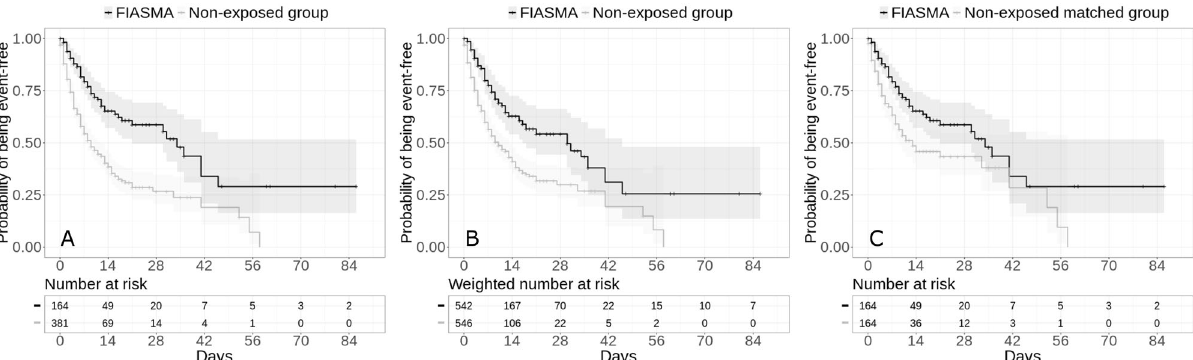
Fig. 2 Kaplan-Meier curves for the composite endpoint of intubation or death among patients with psychiatric disorders hospitalized for severe COVID-19, according to FIASMA psychotropic medication use at baseline. Kaplan – Meier curves for the composite endpoint of intubation or death in the full sample crude analysis ( N = 545) ( A ), in the full sample analysis with IPW ( N = 545) ( B ), and in the matched analytic sample using a 1:1 ratio ( N = 328) ( C ) among patients with psychiatric disorders hospitalized for severe COVID-19, according to FIASMA psychotropic medication use at